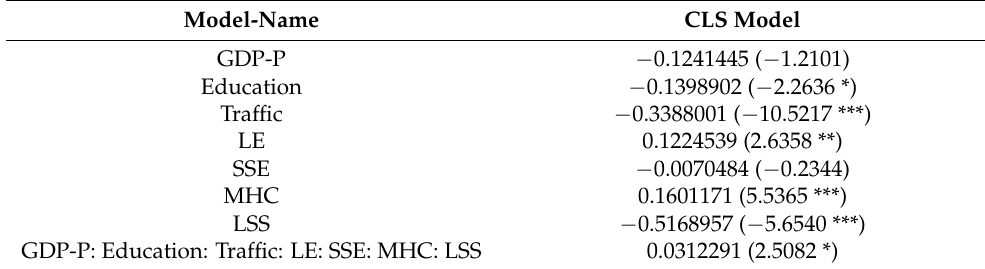
Table 7. Fixed Model results of life satisfaction and CLS model.